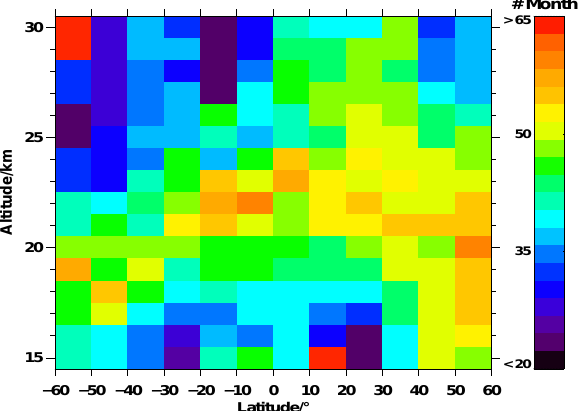
Figure 9. The distribution of the phase shift between the solar max- imum and negative water vapour response over latitude and alti- tude. Positive phase shifts represent a delay of the response of water vapour to the solar cycle.